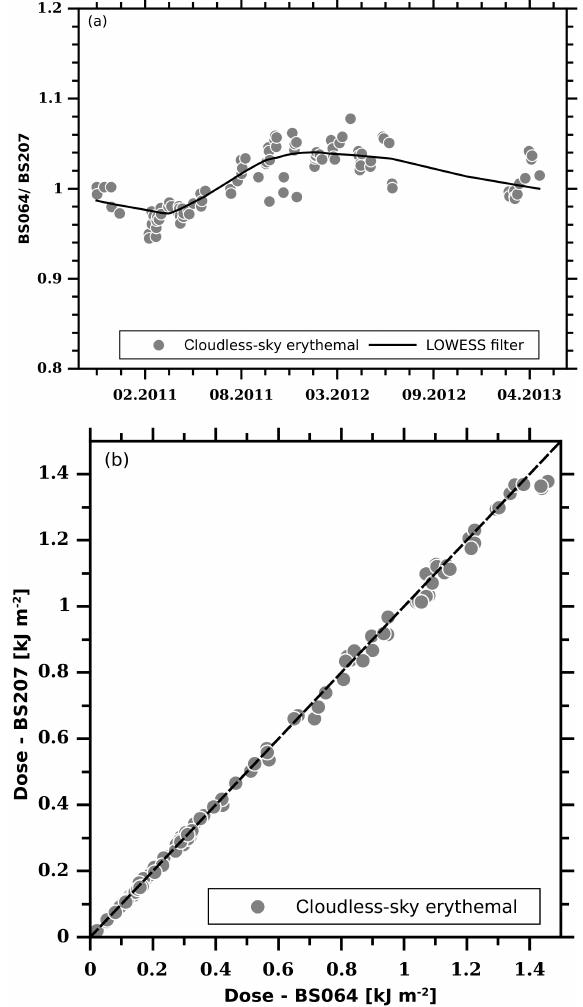
Figure 1. (a) The ratio between erythemal 6h (noon ± 3h) doses measured by the Brewer spectrophotometers Nos. 64 and 207 while working simultaneously at Belsk (all-sky conditions). The solid curve represents the data smoothed by the LOWESS filter. (b) Scat- ter plot of doses measured by Brewer spectrophotometers Nos. 207 and 64.